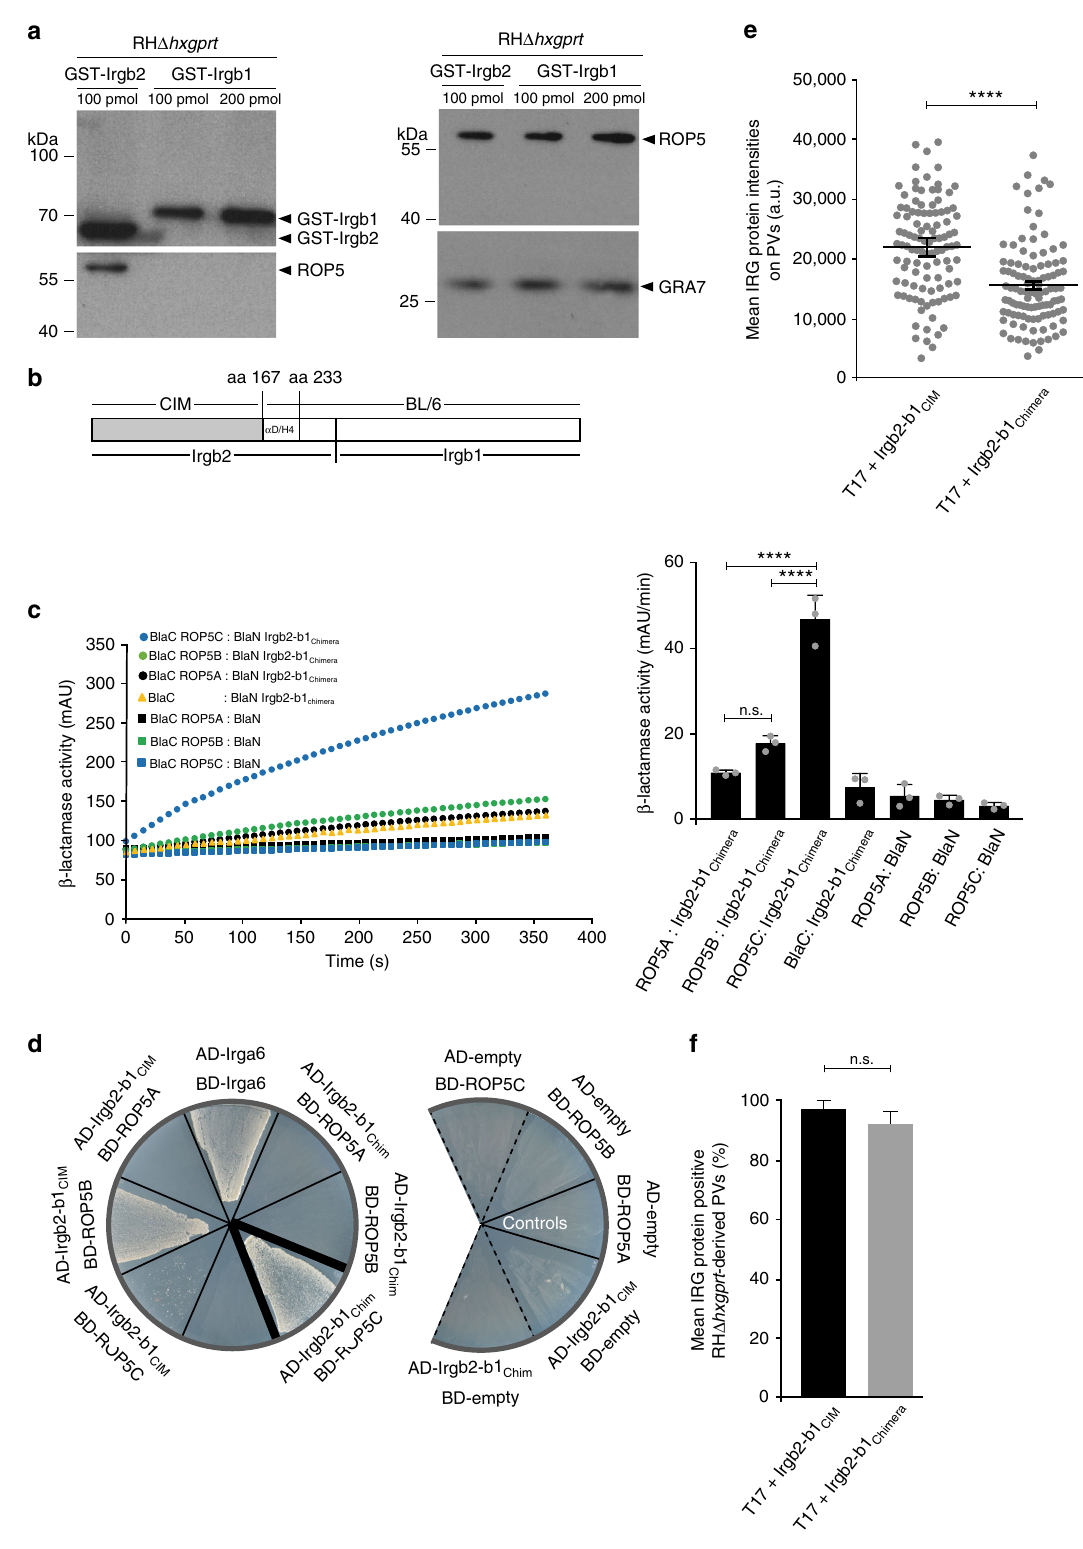
BlaC ROP5C : BlaN Irgb2-b1 Chimera BlaC ROP5B : BlaN Irgb2-b1 Chimera BlaC ROP5A : BlaN Irgb2-b1 Chimera : BlaN Irgb2-b1 chimera BlaC ROP5A : BlaN BlaC ROP5B : BlaN